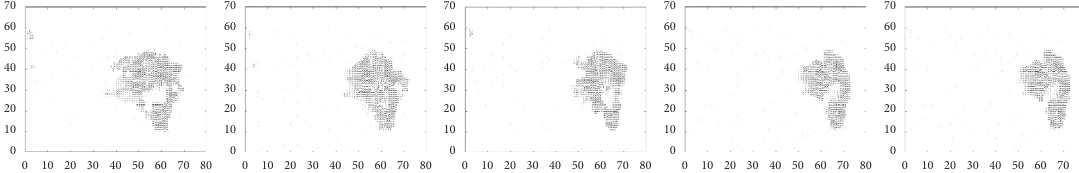
Figure 8: DGF extraction through motion estimation between consecutive gait